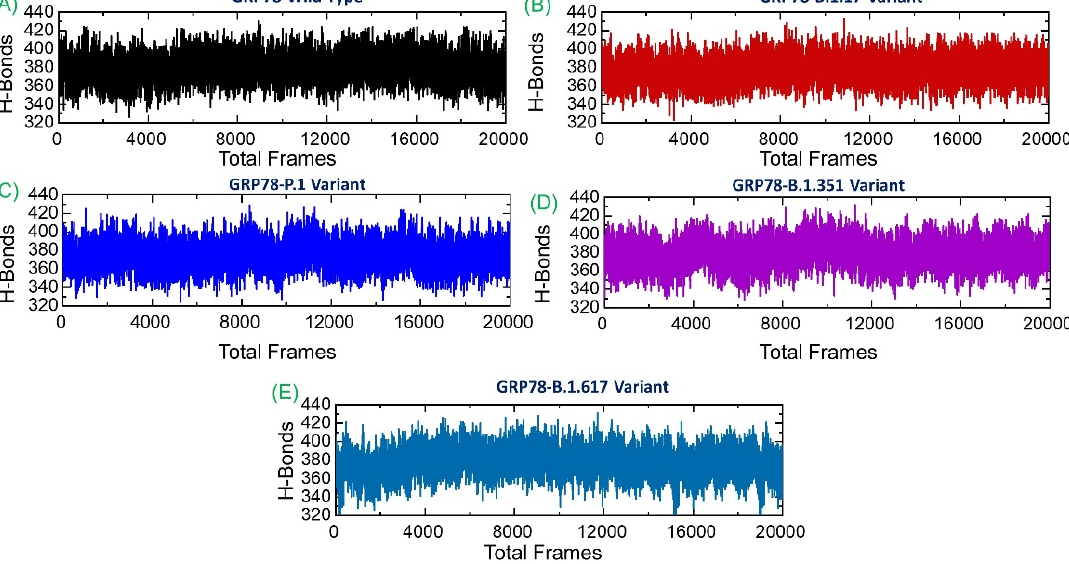
Figure 8. Hydrogen bonding analysis of the wild-type and variant’s complexes. ( A ) shows the total H-bonds of wild-type-RBD-GRP78 complex; ( B ) shows the total H-bonds of B.1.1.7-RBD-GRP78 complex; ( C ) shows the total H-bonds of P.1-RBD-GRP78 complex; ( D ) shows the total H-bonds of B.1.351-RBD-GRP78 complex; ( E ) shows the total H-bonds of B.1.617-RBD-GRP78